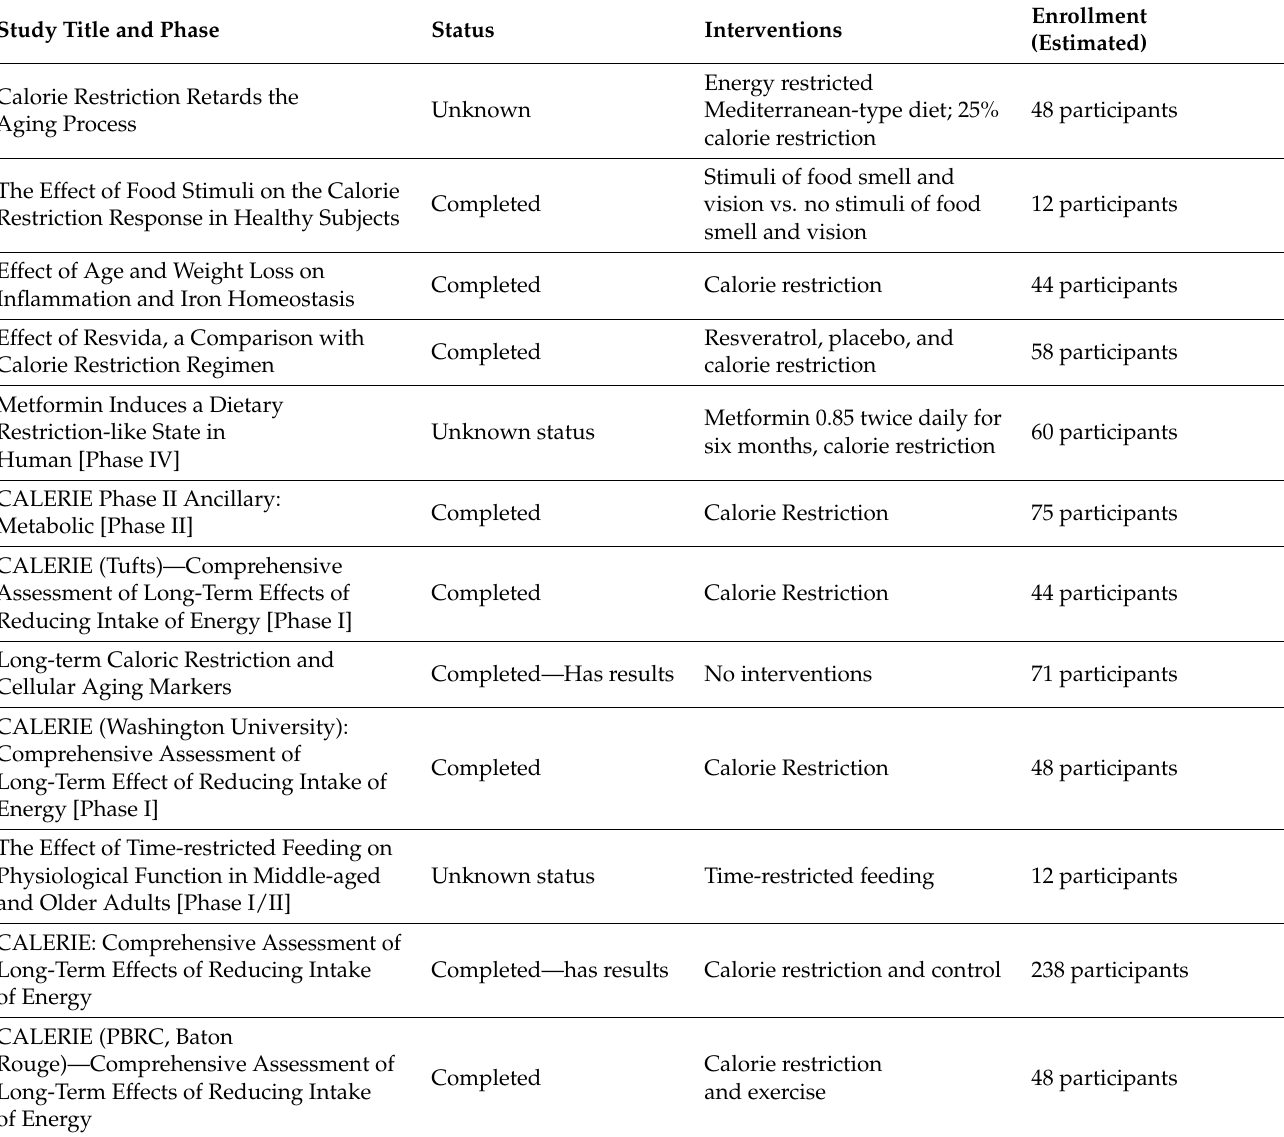
Table 2. Information on clinical trials using calorie-restriction-related interventions in human aging studies (summarized in Figure 2B) including study status, interventions and number of participants. Information gathered from www.clinicaltrials.gov, accessed on 17 March